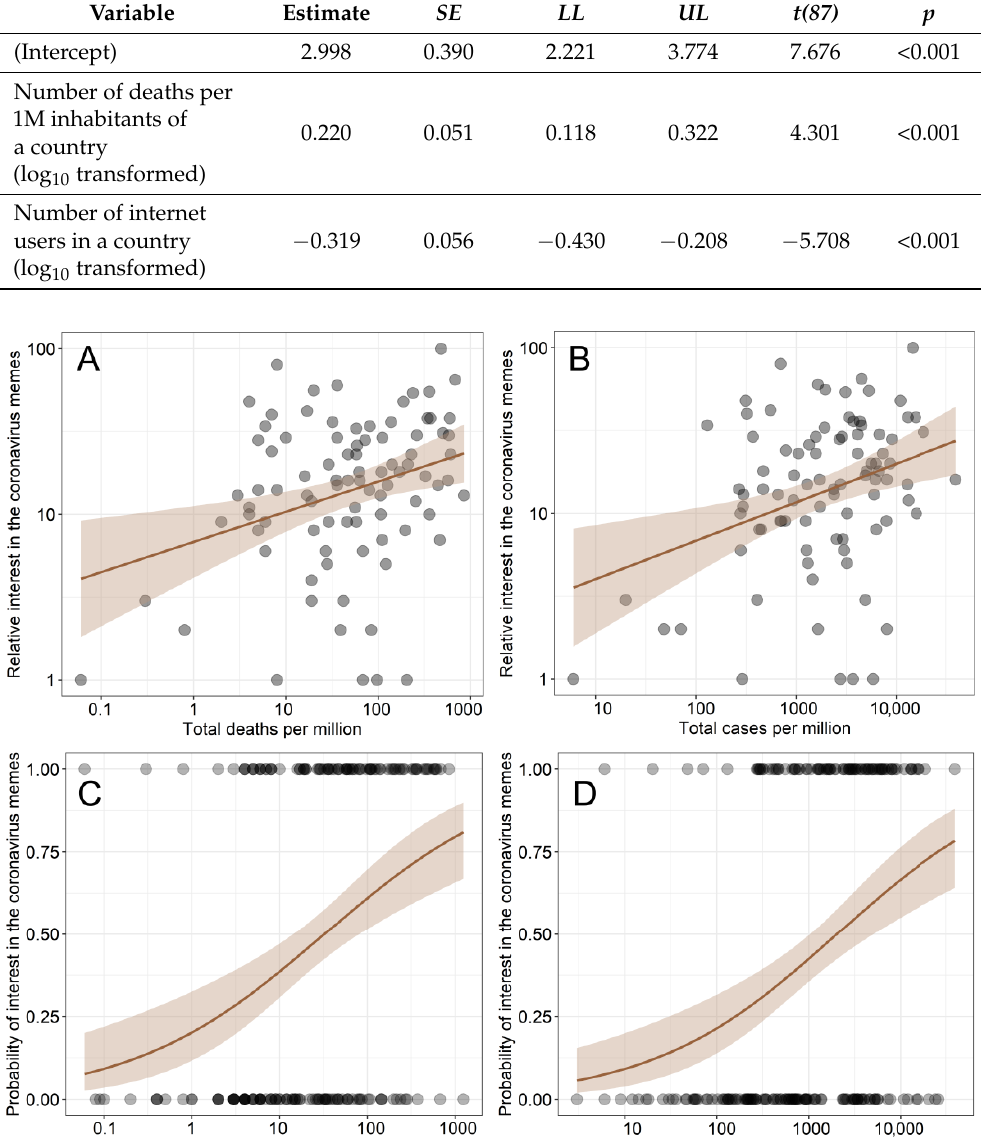
Table 1. Results of the linear model testing the association between the relative interest in coronavirus memes (Google Trends index for search string: “coronavirus meme”) and total number of deaths due to COVID-19 per one million inhabitants and the number of internet users in different countries. Estimates of functions slopes are given with standard errors (SE), 95% confidence intervals (LL–lower confidence intervals, UL–upper confidence intervals) and t –test (with residual degree of freedom). Model explained 33% variation in data (adjusted R 2 ).